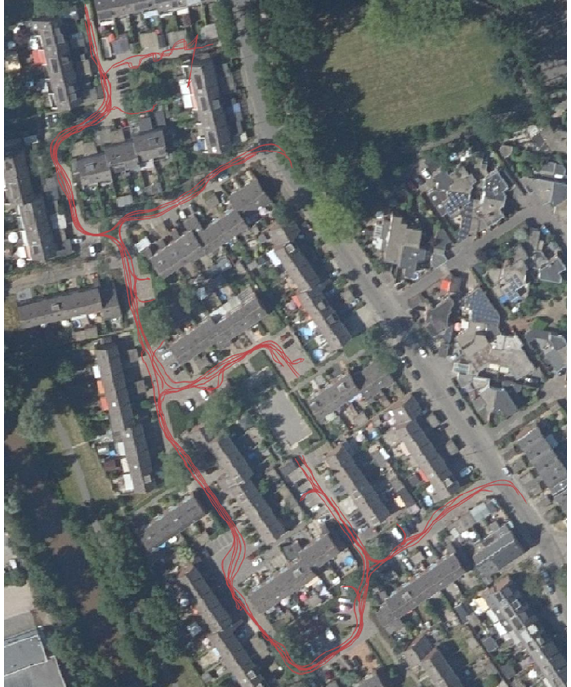
Figure 2. Lines of measurement in Griffiersveld.